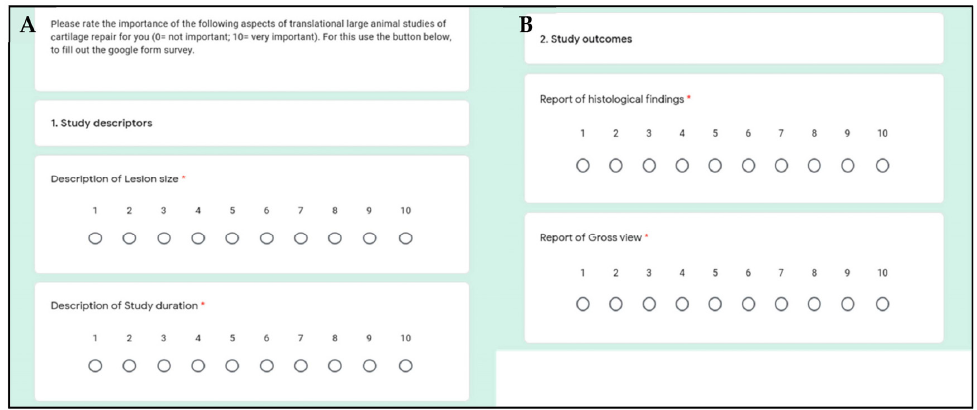
Figure 1. Example of the internet-based survey. ( A ) First two survey items regarding study